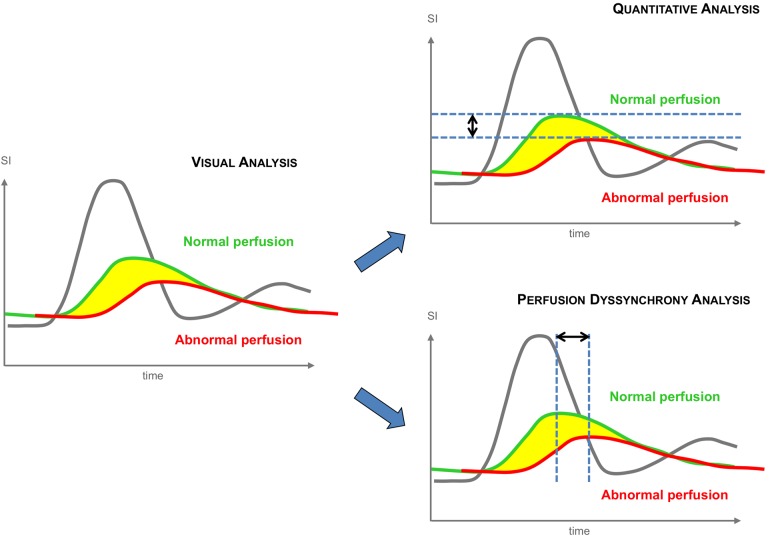
Areas of abnormal myocardial perfusion are characterized by reduced and delayed wash-in of contrast agent. These features are the basis for visual analysis. Quantitative analysis detects and measures absolute differences of perfusion (vertical arrow). To achieve this, myocardial signal intensity curves require temporal realignment before deconvolution with the arterial input function. This is particularly important when high-resolution voxel-wise perfusion quantification is performed. Dyssynchrony analysis instead does not take into account changes in the amplitude of signal intensity but rather isolates and measures the temporal dyssynchrony of the wash-in curves (horizontal arrow). SI, signal intensity.